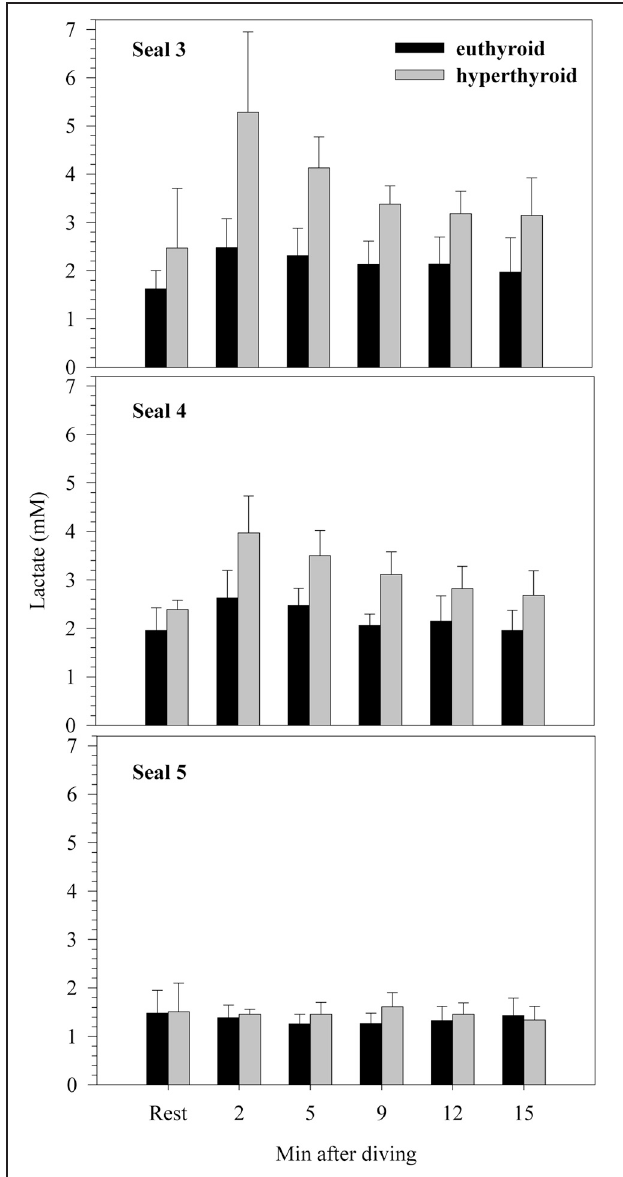
FIGURE 3 | Resting and post-dive lactate concentrations (mM) for three individual harbor seals (values are means ± SD; n = 5 trials per seal and